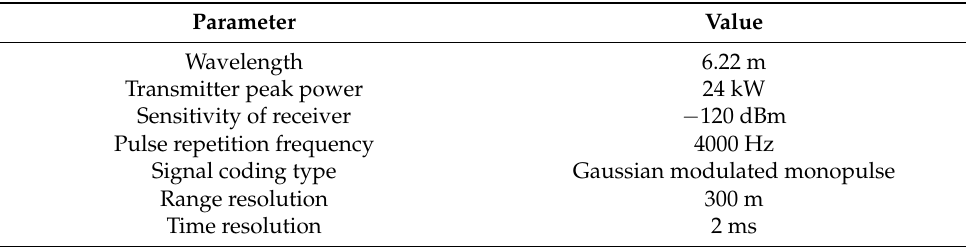
Table 1. Leshan VHF radar operational